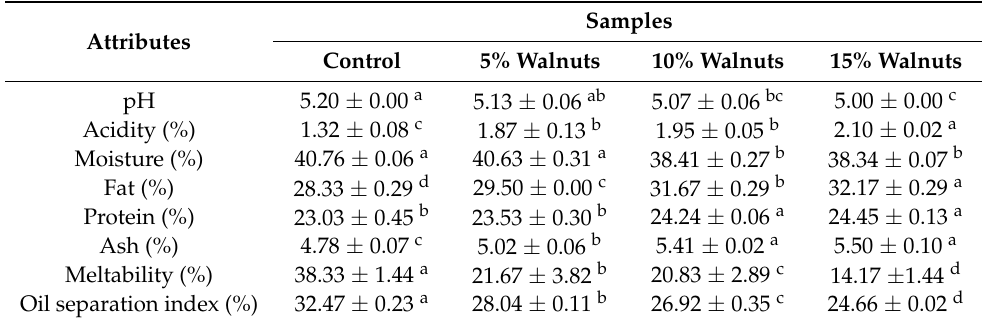
Table 1. Physiochemical and functional characteristics of processed cheeses containing 0, 5, 10 and 15% walnut paste. Attributes